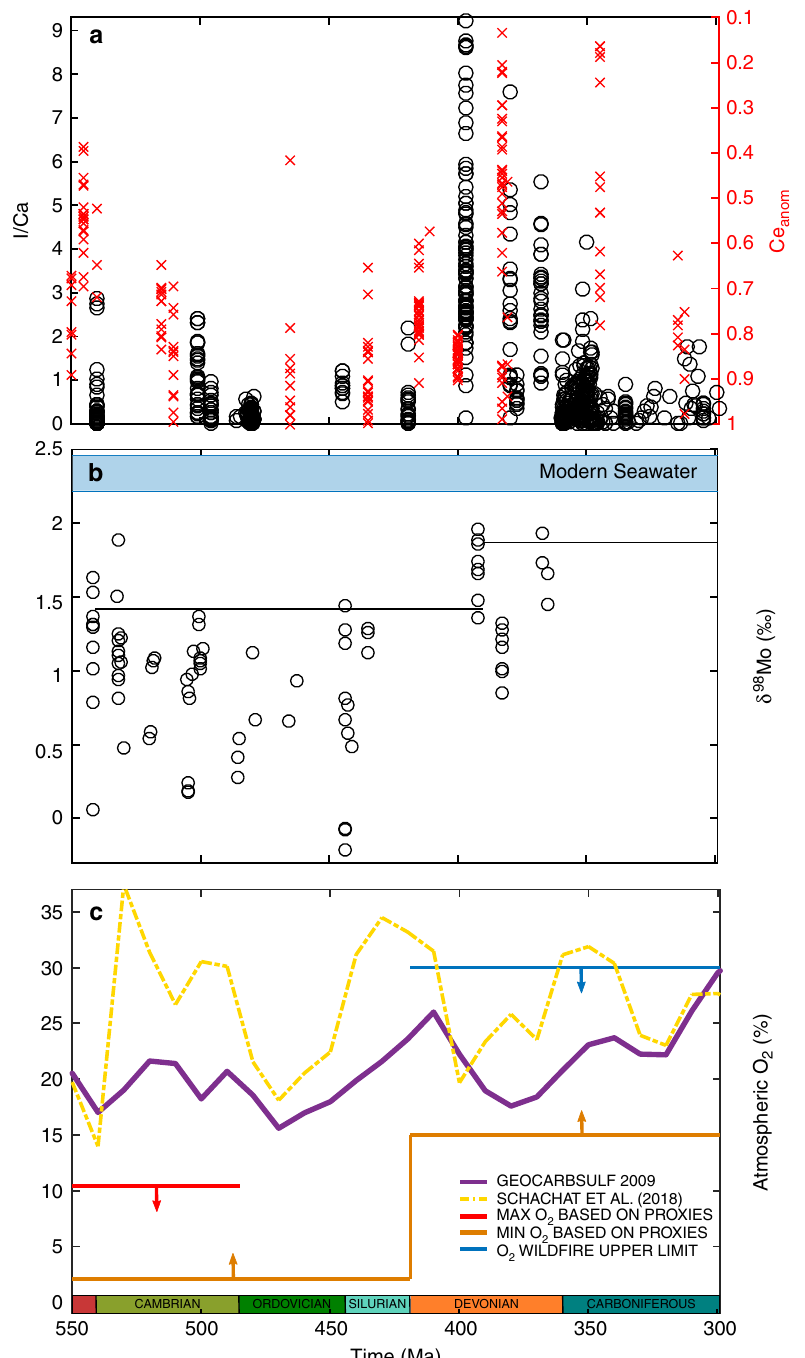
Fig. 1 Atmospheric O 2 levels during the early-mid Paleozoic predicted by GEOCARBSULF, compared to geochemical proxy data. a Iodine to calcium ratios 50 , and cerium anomaly data 15 , taken from marine carbonates. Note: higher iodine to calcium ratios, and lower cerium anomaly values indicate oceanic oxygenation. b Molybdenum isotope values for the early to mid-Paleozoic, where the solid black lines represent 90% percentiles for the two time periods 11 . c The purple line represents the atmospheric O 2 output from GEOCARBSULF 21 , the yellow dot-dash line shows recent work to update the δ 13 C record in GEOCARBSULF 30 , and the red line shows the approximate maximum atmospheric O 2 (10.4% atm) for the Cambrian and earlier, based on geochemical water column redox data and allowing for modelling uncertainties 14,72,73 . The orange line is the approximate O 2 minimum, based on the same redox data, as well as Cambrian biota and wild fi re oxygen requirements 2,4,14 . The blue line is a likely oxygen maximum, based on wild fi re feedbacks, but geochemical mass balance studies suggest p O 2 levels as high as 35% atm may be permissible